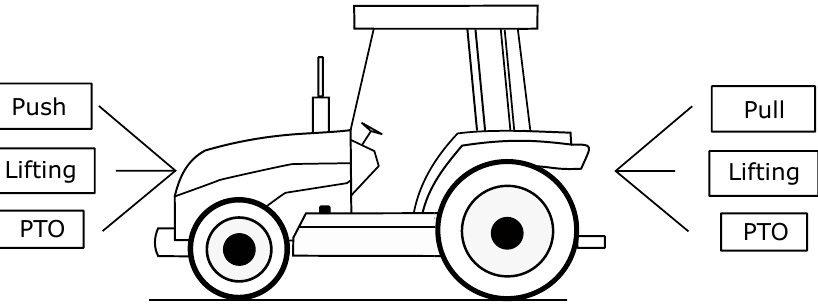
Figure 1. Schematic representation of an orchard tractor and its main duties.